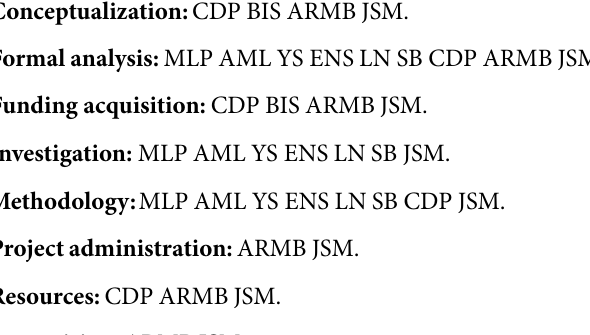
S2 Fig. Flow cytometryanalysis of yeast expressing peptide F5. (A) Entire yeast population detected by forward and side scatter (FSC and SSC respectively). (B) Expressing (main peak) and non-expressing (minor peak) fractions of yeast population, detected with anti-SV5 anti- body conjugated to phycoerythrin (PE). (C) Yeast binding (main peak) or non-binding (minor peak) to biotinylated, glutamine-bound PBP, as detected with Alexa din (APC). (D) The expressing and binding yeast population (carrying APC as well as PE fluo- rescence) is shown in